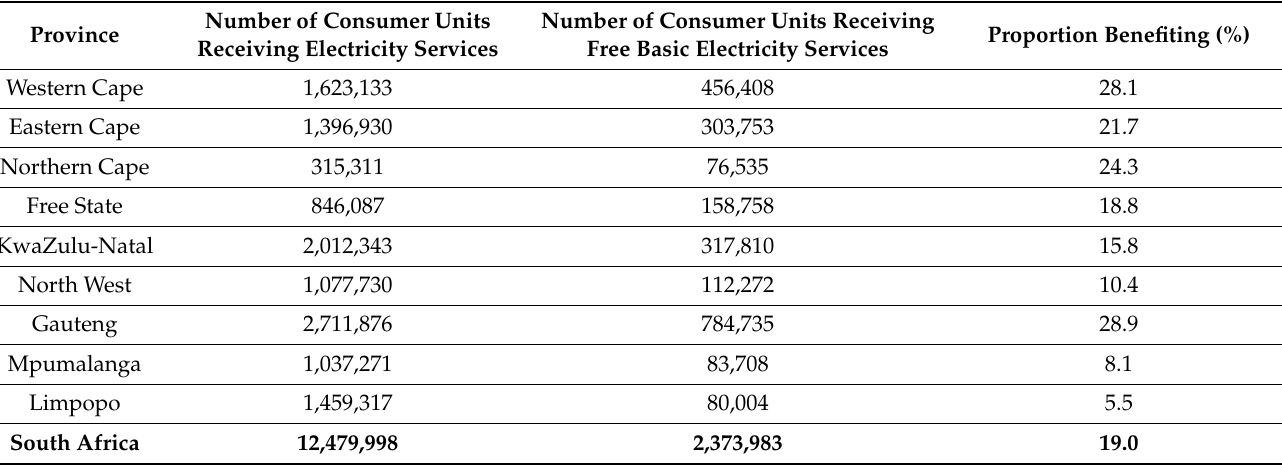
Table 6. Number of indigent households in each province provided with free basic alternative energy, 2020. Province